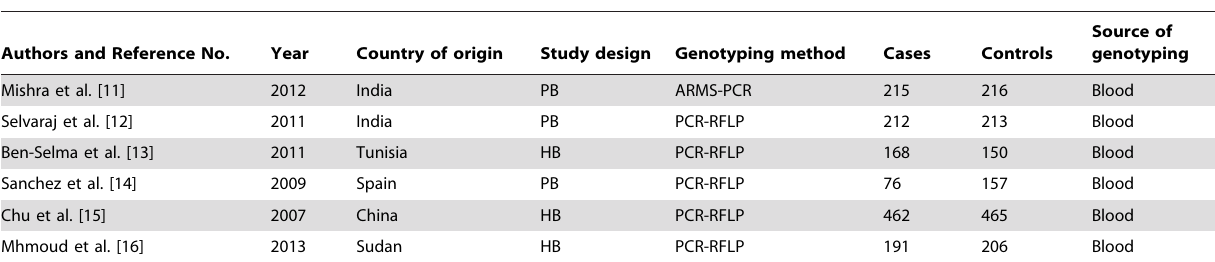
Table 1. Major characteristics of the studies included in the meta-analysis.